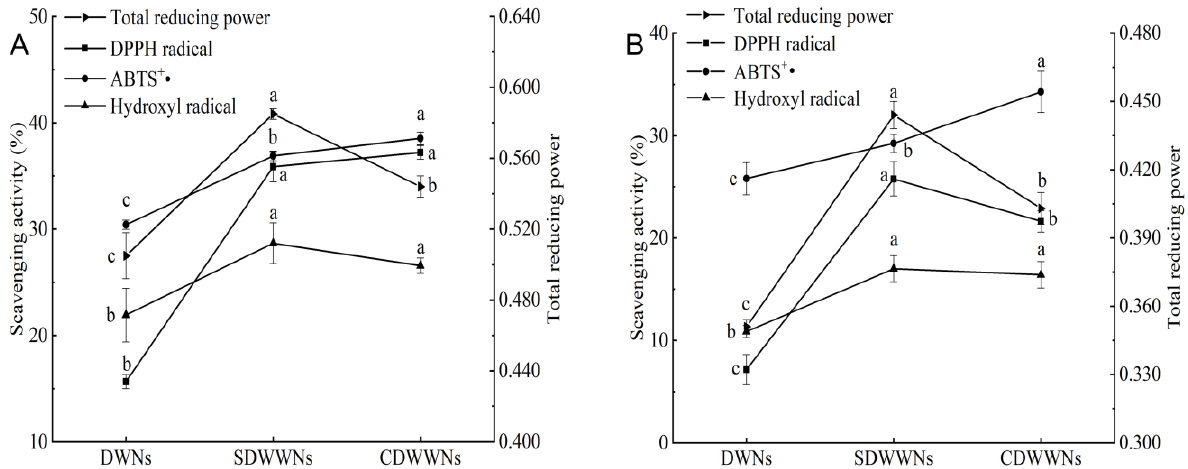
Figure 3. In vitro antioxidant activity of the raw and cooked noodles. ( A ) raw noodles; ( B ) cooked noodles. DWNs, dried wheat noodles; SDWWNs, stone-milled dried whole wheat noodles; CD- WWNs, commercially dried whole wheat noodles. Different letters indicate significant differences in the same indicator data ( p <